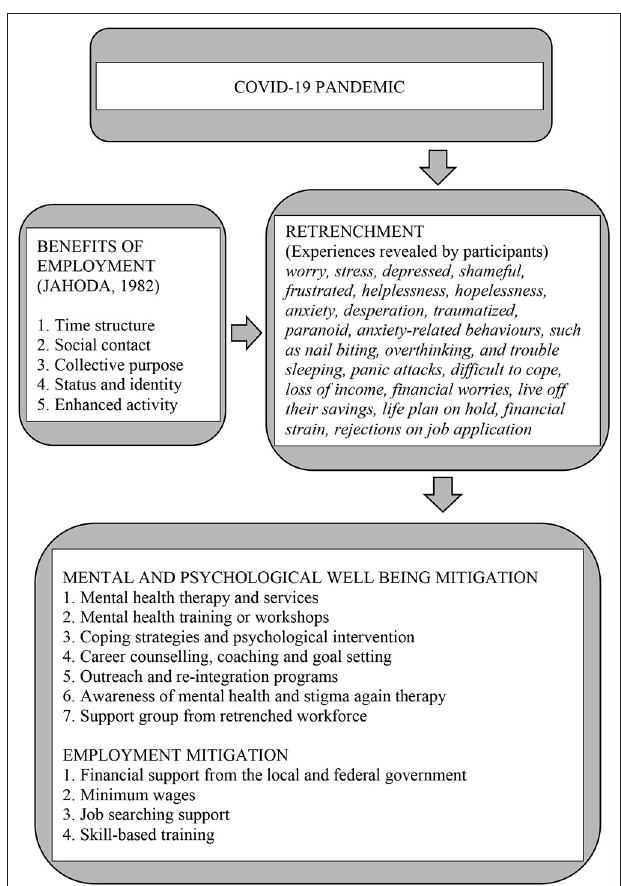
FIGURE 3 | The proposed